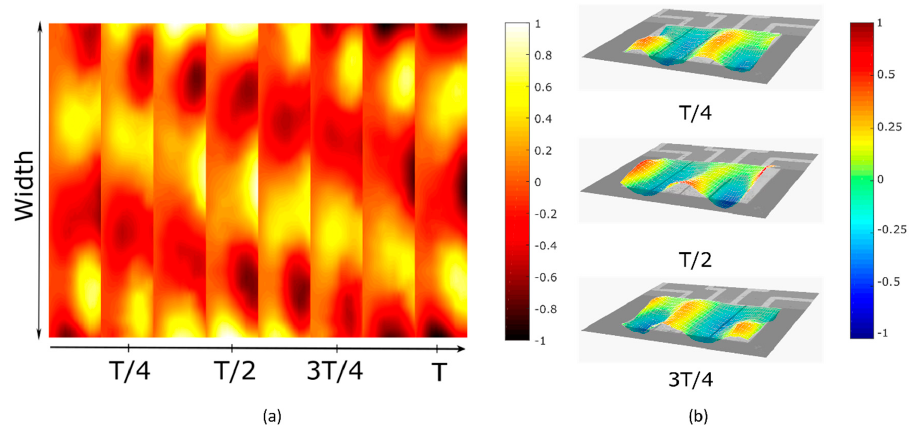
Figure 7. Snapshots of different times of the measured TW in isopropanol at 583.2 kHz: ( a ) 2D representation and ( b ) 3D representation (a video clip is available (Video S3)). The colors represent the normalized displacement of the cantilever. T corresponds to the period of the TW.